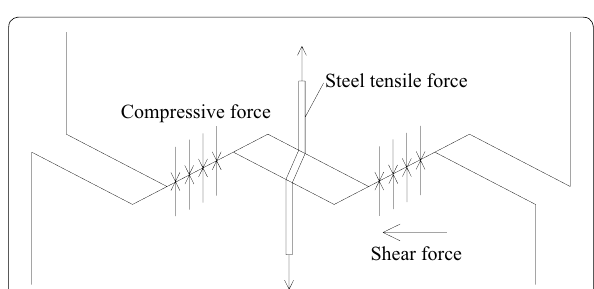
Fig. 10 Schematic diagram of shear‑friction theory.